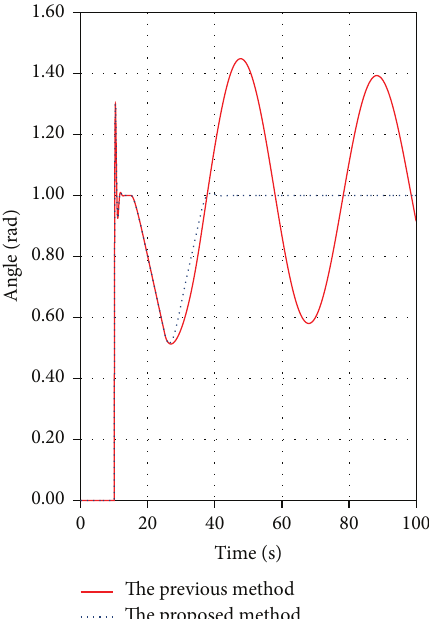
Figure 3: Simulation results for the plant with the dead time 10(s).